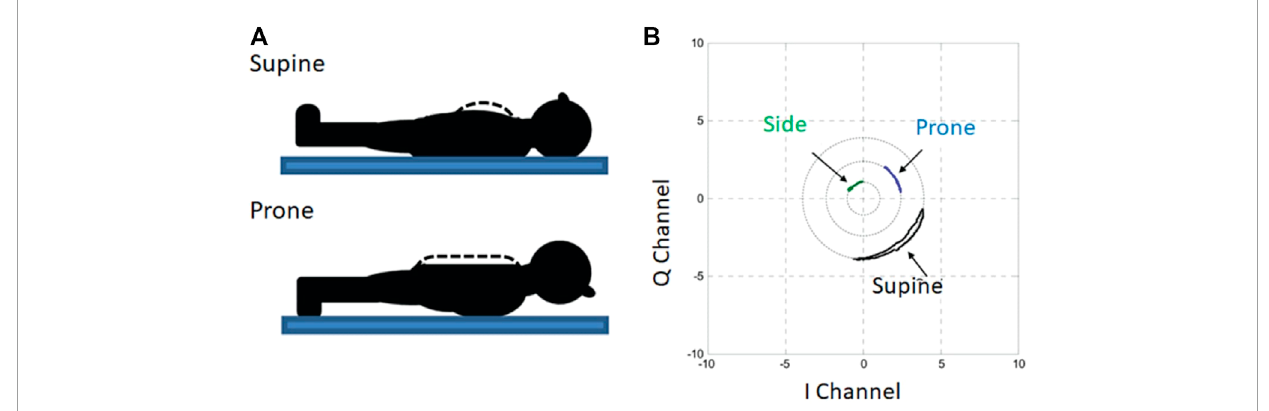
FIGURE 5 Doppler radar measurements used to assess posture of recumbent subjects. The effective radar cross section (ERCS) changes depending on the size of the body surface moving with respiration, which changes with recumbent posture (A) . Analysis of the I-Q plot reveals the correspondence between posture and ERCS through the plotted arc radius (B) (Kiriazi et al., 2021).